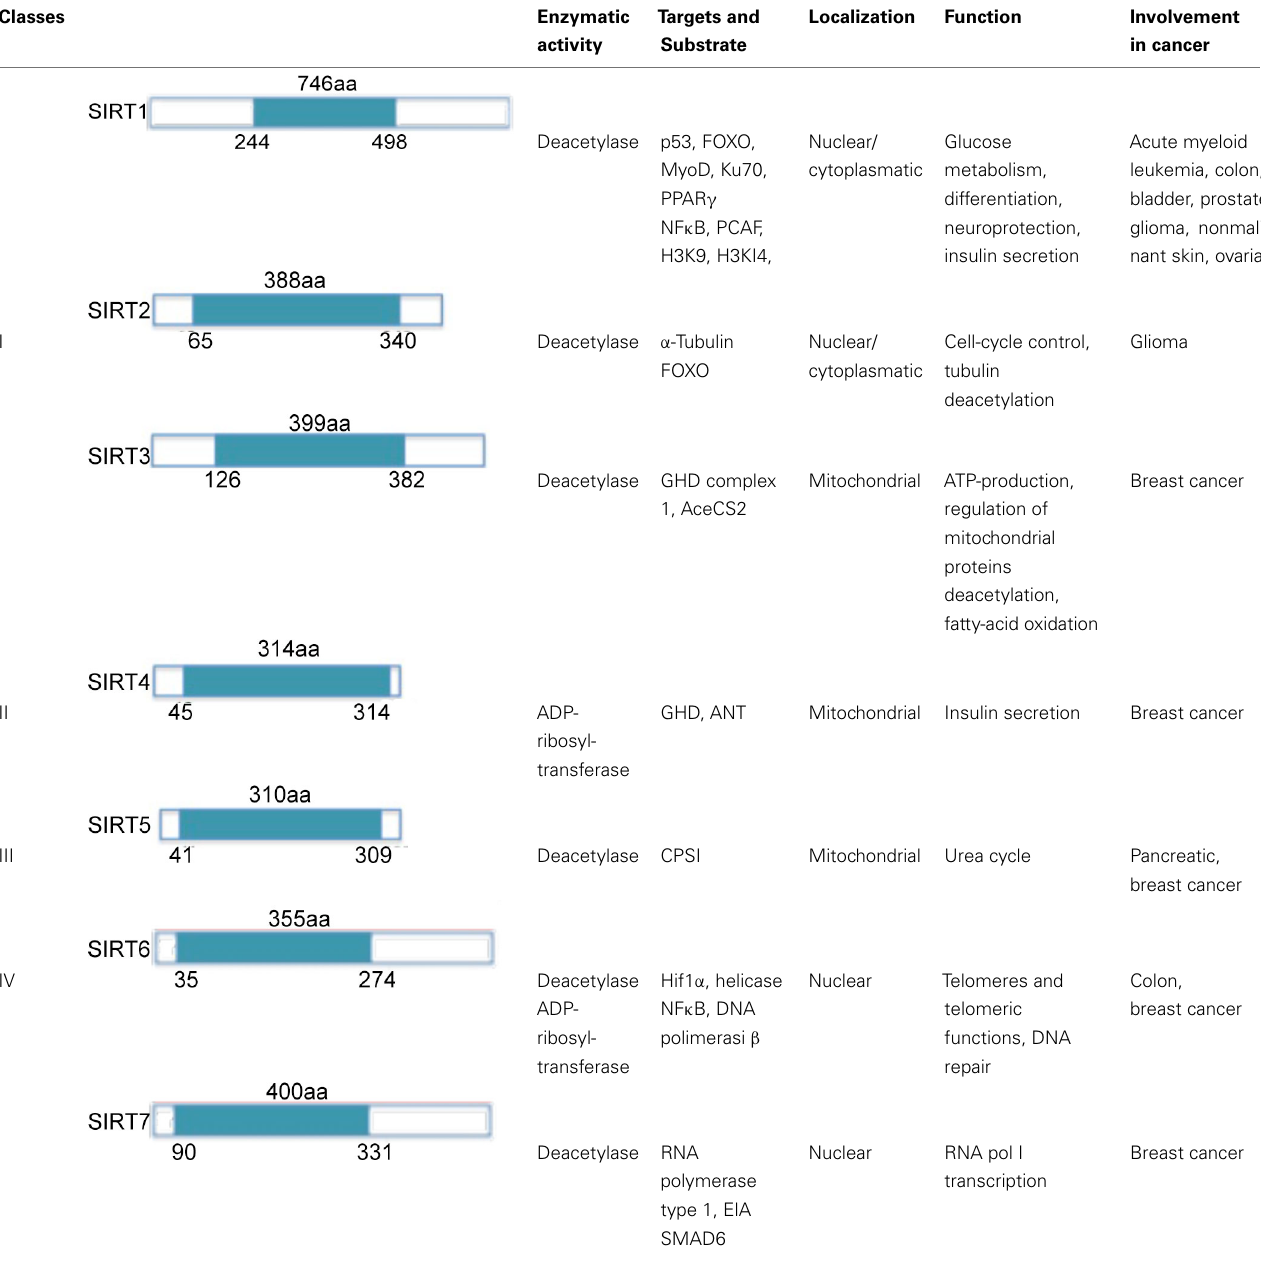
Table 1 | Diversity of human